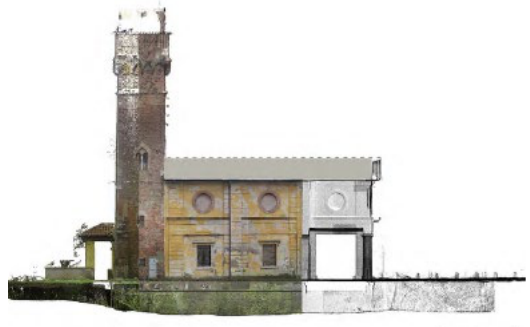
Figure 6 . West facade. From left to right: coloured point cloud, orthoimage, and false-colour point cloud.